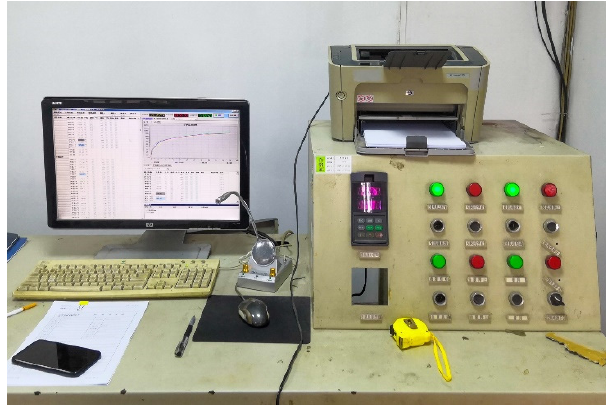
Figure 5. Temperature control and data collection